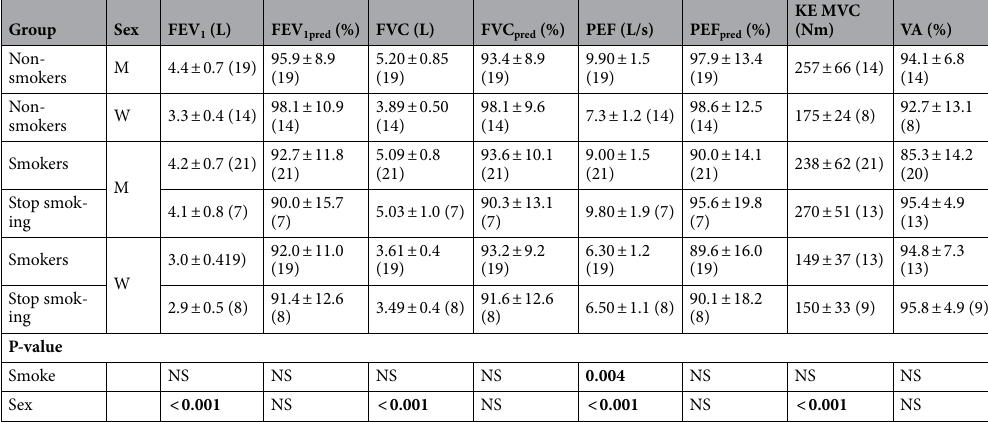
Table 4. The effect of smoking and smoking cessation on spirometry, maximal isometric voluntary knee extension torque (KE MVC) and voluntary activation (VA). All data are presented as mean ± SD; FEV 1 : Forced expiratory volume in one second; FVC: Forced vital capacity; PEF: Peak expiratory flow; PEF pred (%): PEF predicted percentage; (x) denotes number of participants. Significant effects are denoted in bold; NS: not significant.